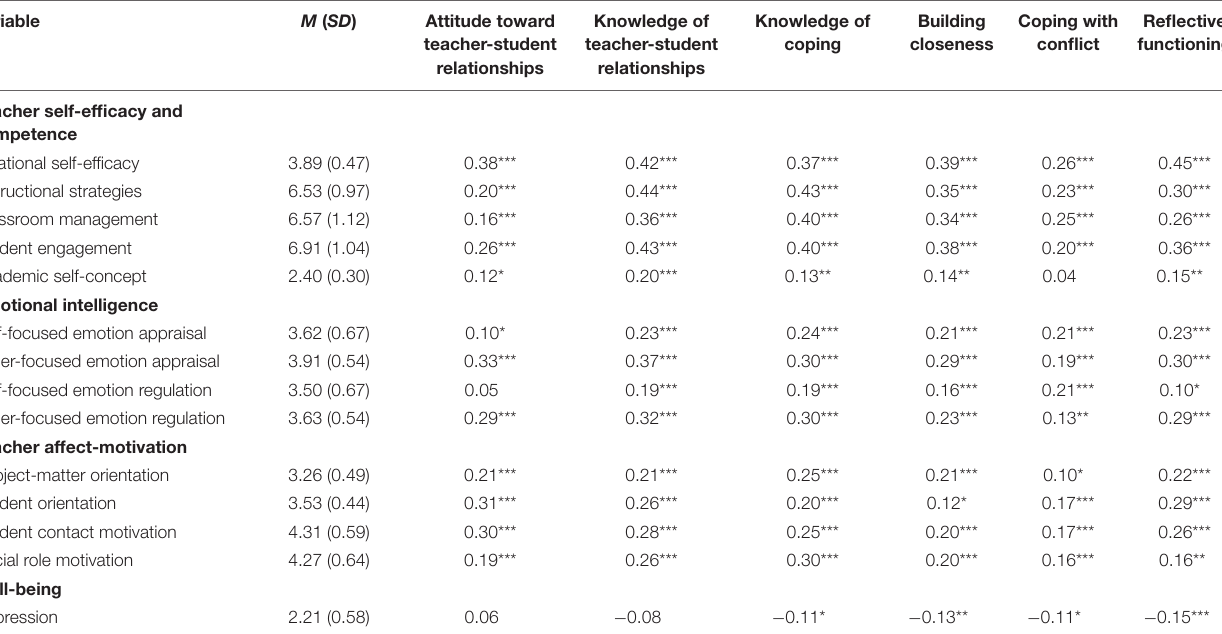
TABLE 10 | Correlations between COMMIT subscales and related measures.